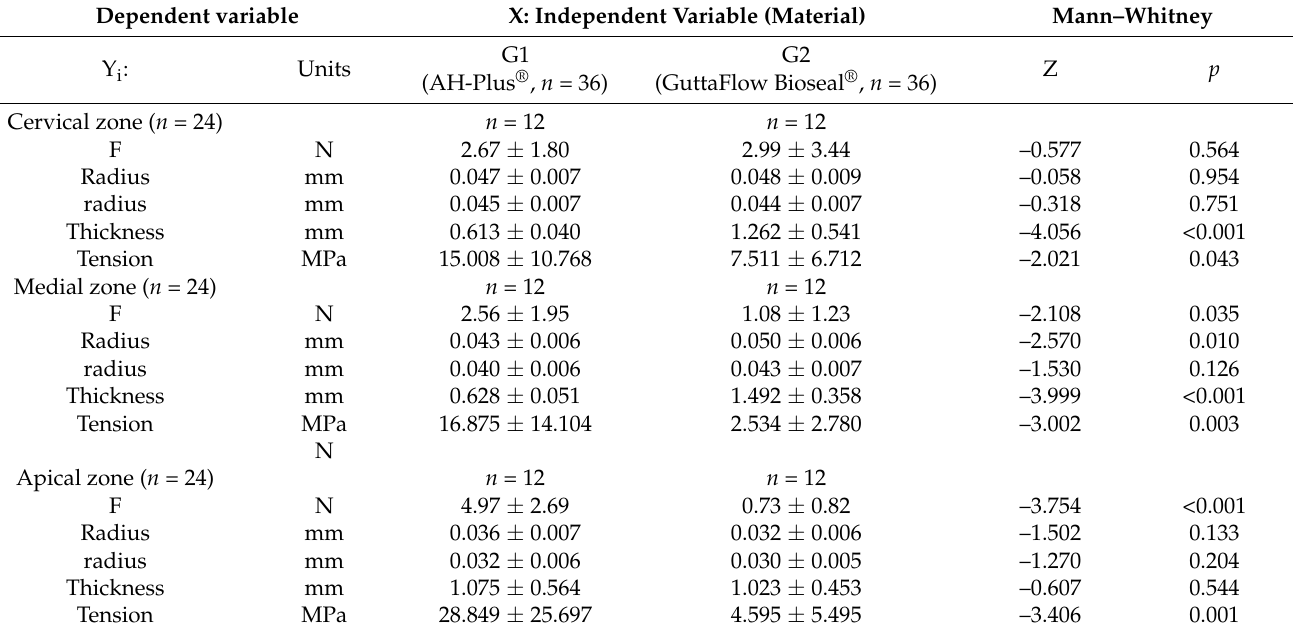
Table 5. Means and standard deviations by group and zone and results of the comparison of the endodontic